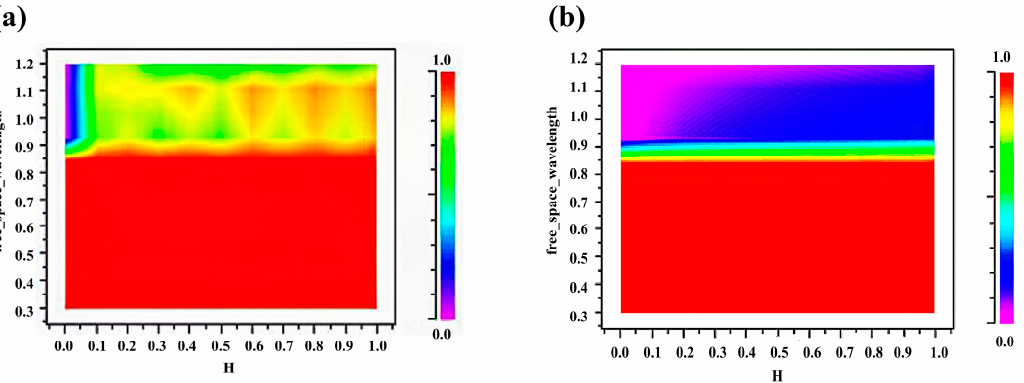
Figure 5. ( a ) The dependance of the absorption efficiency of the absorption layer with KNbO 3 column hexagon scatterers on thickness H . ( b ) The dependance of the absorption efficiency of the absorption layer with the air-hole hexagon scatterers on thickness H.